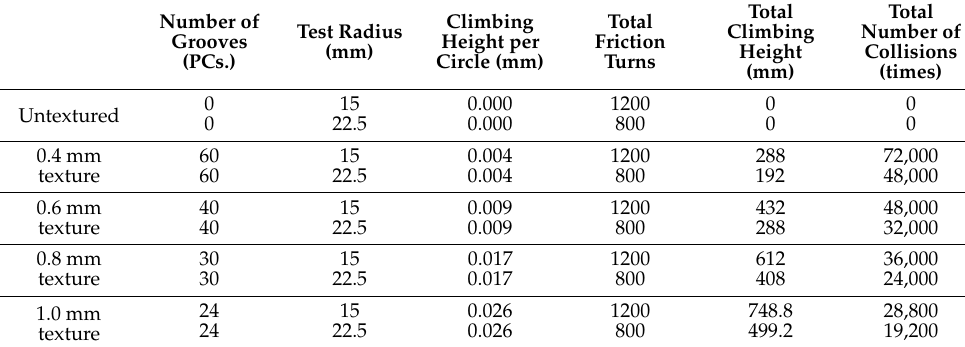
Table 5. Collision parameters with different rotation radii. Number of Grooves